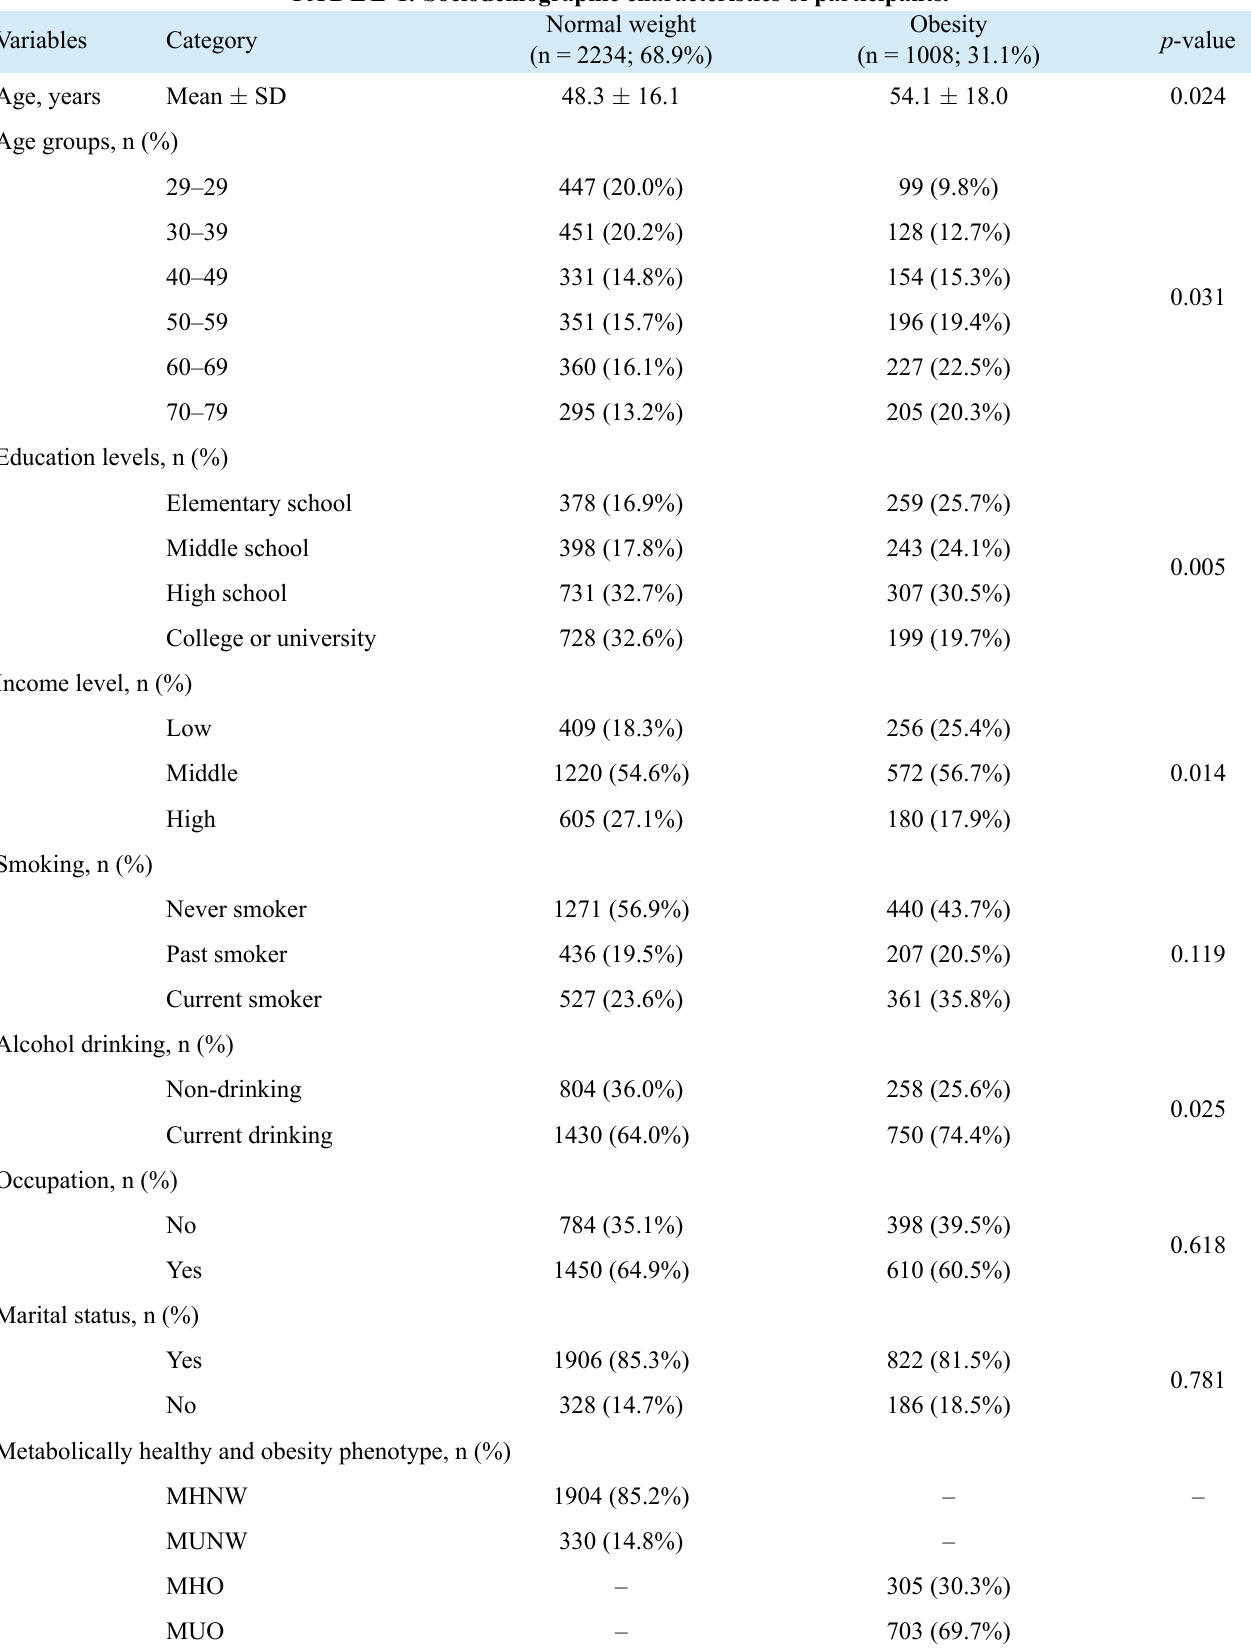
TABLE 1. Sociodemographic characteristics of